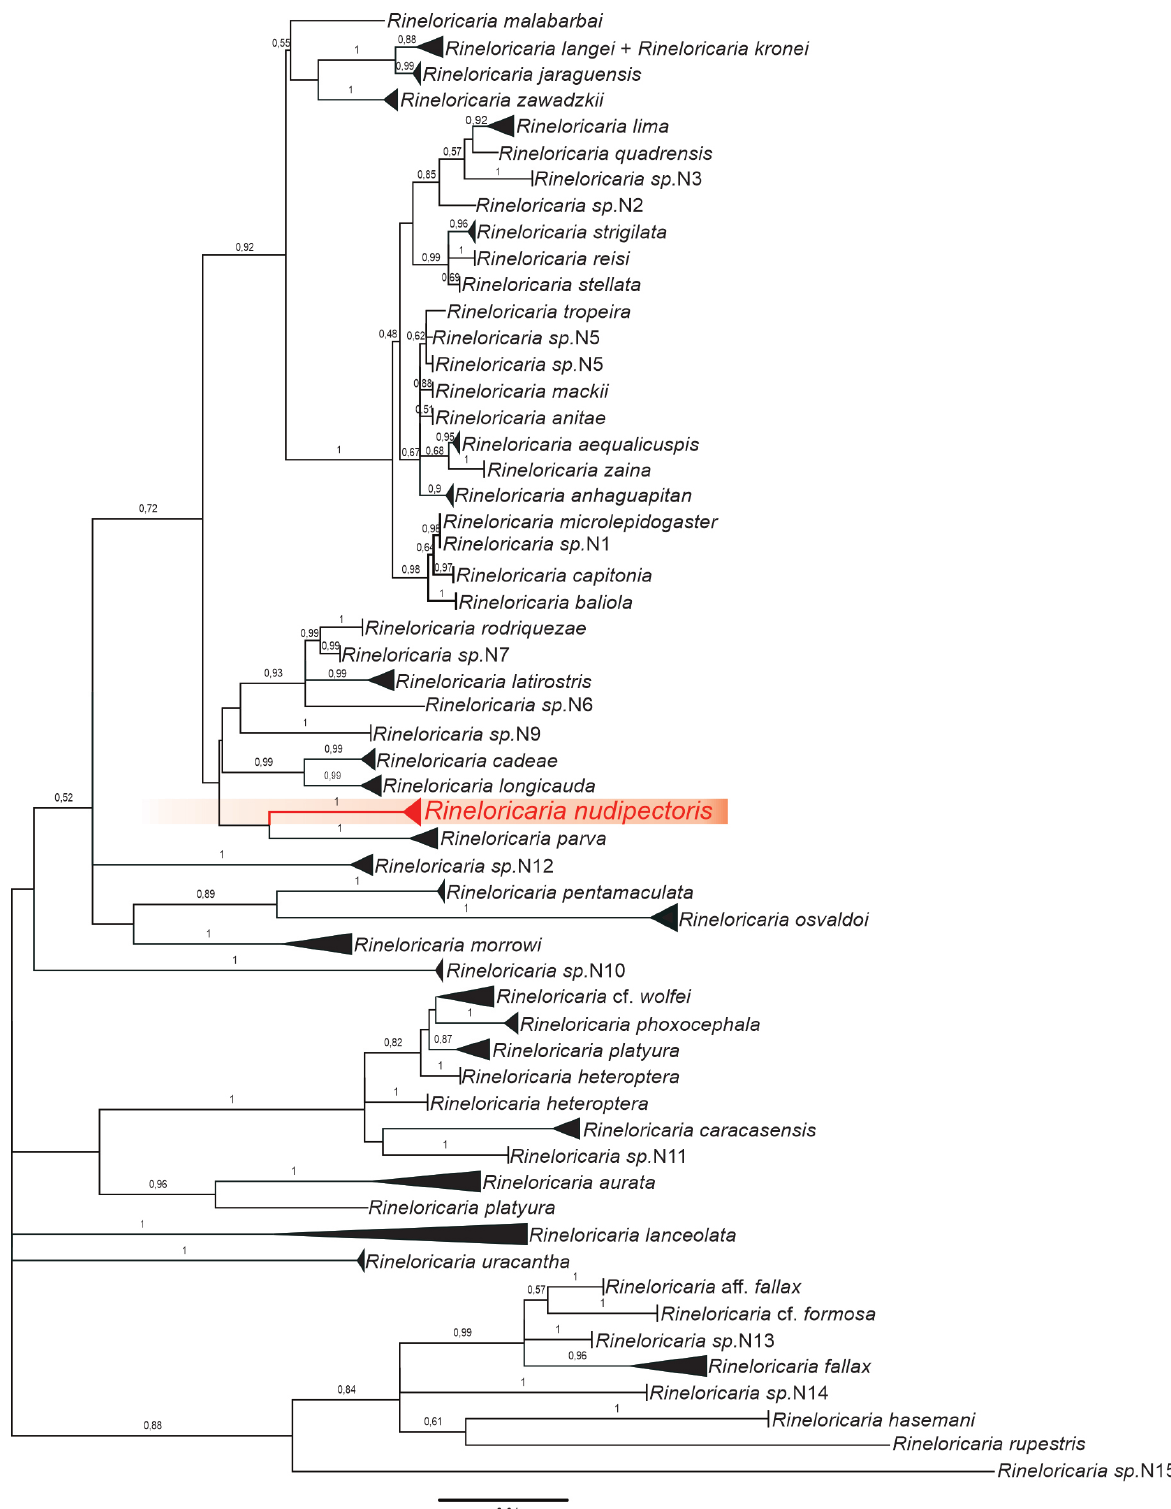
FIGURE 6 | Maximum Likelihood tree based on the sequences of the cytochrome c oxidase subunit I gene under the GTR+G+I model. The numbers at each branch indicate the bootstrap values (100 pseudoreplicates), except for those below 0.5 which were suppressed. Branches are collapsed based on Costa-silva et al .